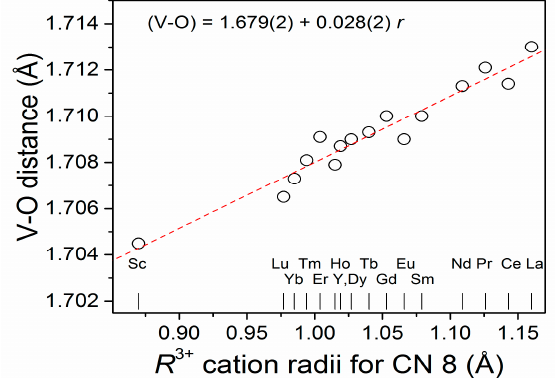
Figure 10. The V–O distances in the tetragonal zircon-type orthovanadate series as a function of eight-coordinated R 3+ cations after Shannon [15]. Corresponding values were evaluated from the structural data of R VO 4 compounds published in References [13,34,35].